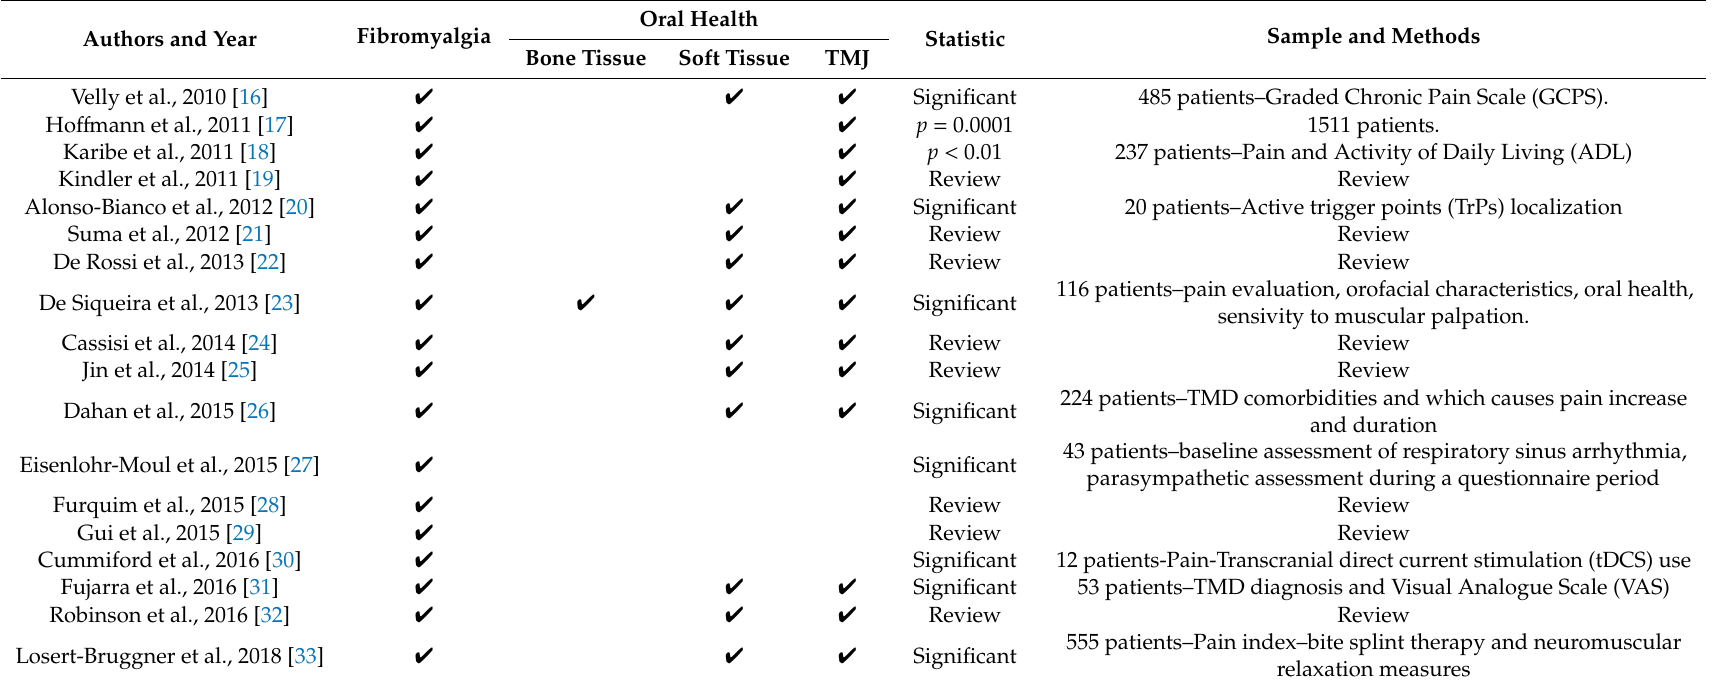
Table 2. Synthesis of results (see Section